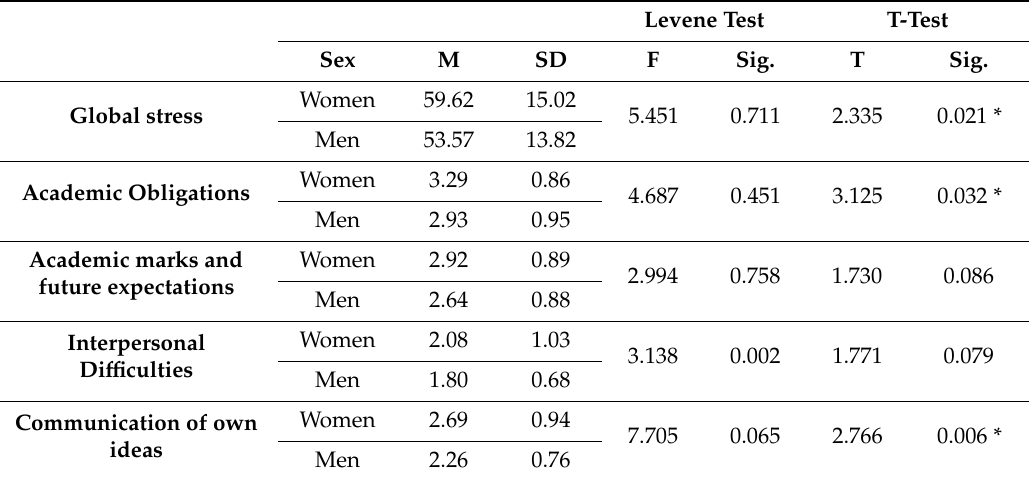
Table 1. Academic stress according to sex.